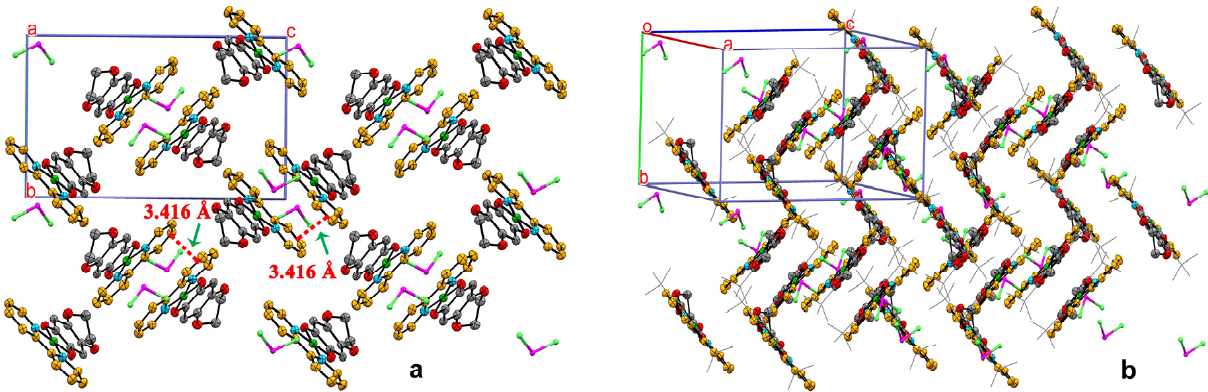
Figure 4. Views of crystal packing fragments of 2 (two unit cells) with 50% thermal probability ellipsoids. Tert -butyl groups (view ( a )) and hydrogen atoms are omitted for clarity. Carbon atoms of diimines are orange-colored. View ( b ) demonstrate short π – π intermolecular